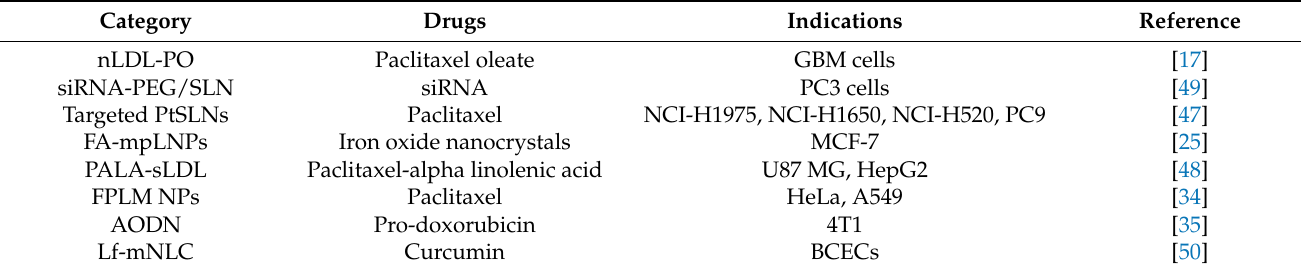
Table 3. sLDL-drugs and applications.